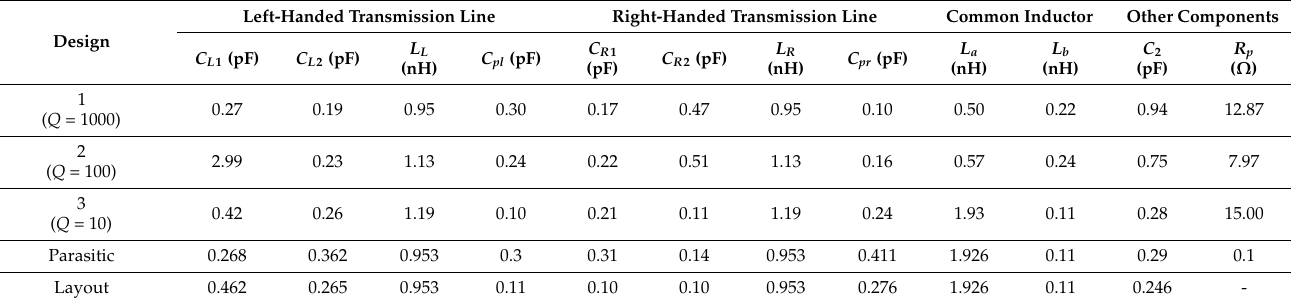
Table 2. Component values of various balun